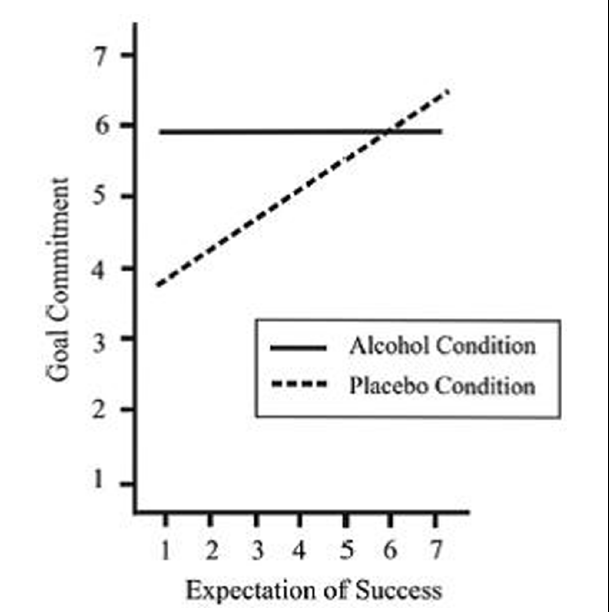
FIGURE 1 | Regression lines depict the link between expectations of success and goal commitment as a function of condition (alcohol vs. placebo). From Sevincer and Oettingen (2009, Study